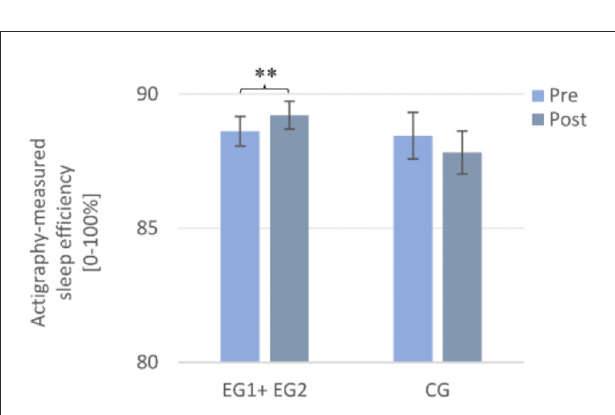
FIGURE5 Actigraphy-recorded changes in sleep efficiency from pre to post in the sleep intervention group (EG1 + EG2) compared to the waiting-list control group (CG). Note that the sleep intervention group improved significantly from pre to post in actigraphy-measured sleep efficiency. Pre- and post-measurements were assessed daily and averaged over a week each. Asterisks represent significant results, ** p < 0.01. Error bars display ± 1 standard error. EG1 + EG2, pooled sleep intervention group (experimental group 1 + experimental group 2); CG, control